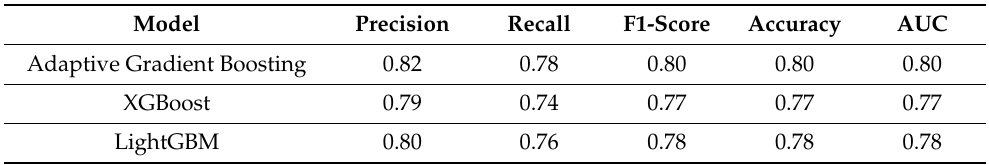
Table 2. The Classification Performance of Various Machine Learning Models for the Stroke Group classification using EEG